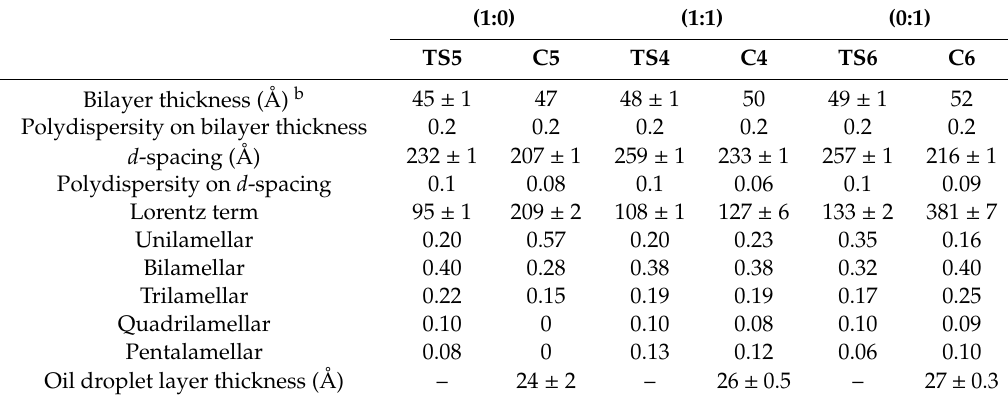
Table 2. Model fitted parameters for the Small-Angle Neutron Scattering (SANS) profiles at 298 K of ternary systems (TS4–TS6) a and aqueous creams (C4–C6) and containing 10% w / w emulsifier concentration and either a 1:1, 1:0 or 0:1 ratio of hexadecanol:octadecanol